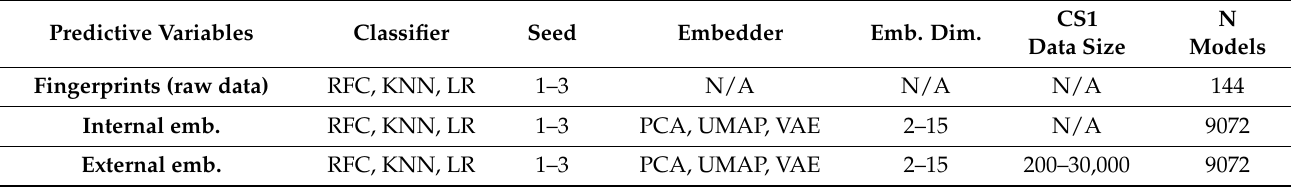
Table 6. Experimental matrix. See abbreviations below the